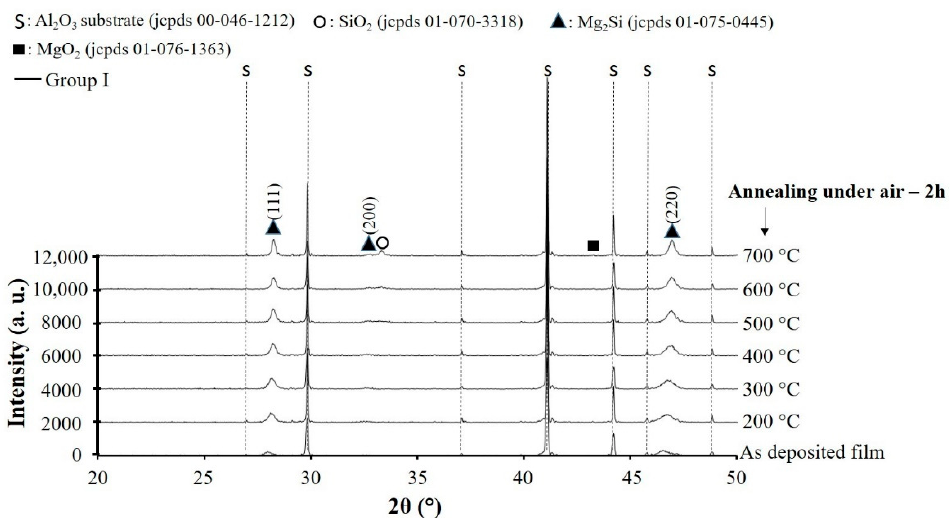
Figure 6. X-ray diffraction patterns of Mg 2 Si coating with suitable composition in Group I ( R P < 7 × 10 − 4 Pa) deposited on alumina substrate and post annealed in air for 2 h at different temperatures. Top surface, X-ray mapping and brittle fracture cross-section of Mg 2 Si film on Al 2 O 3 substrate